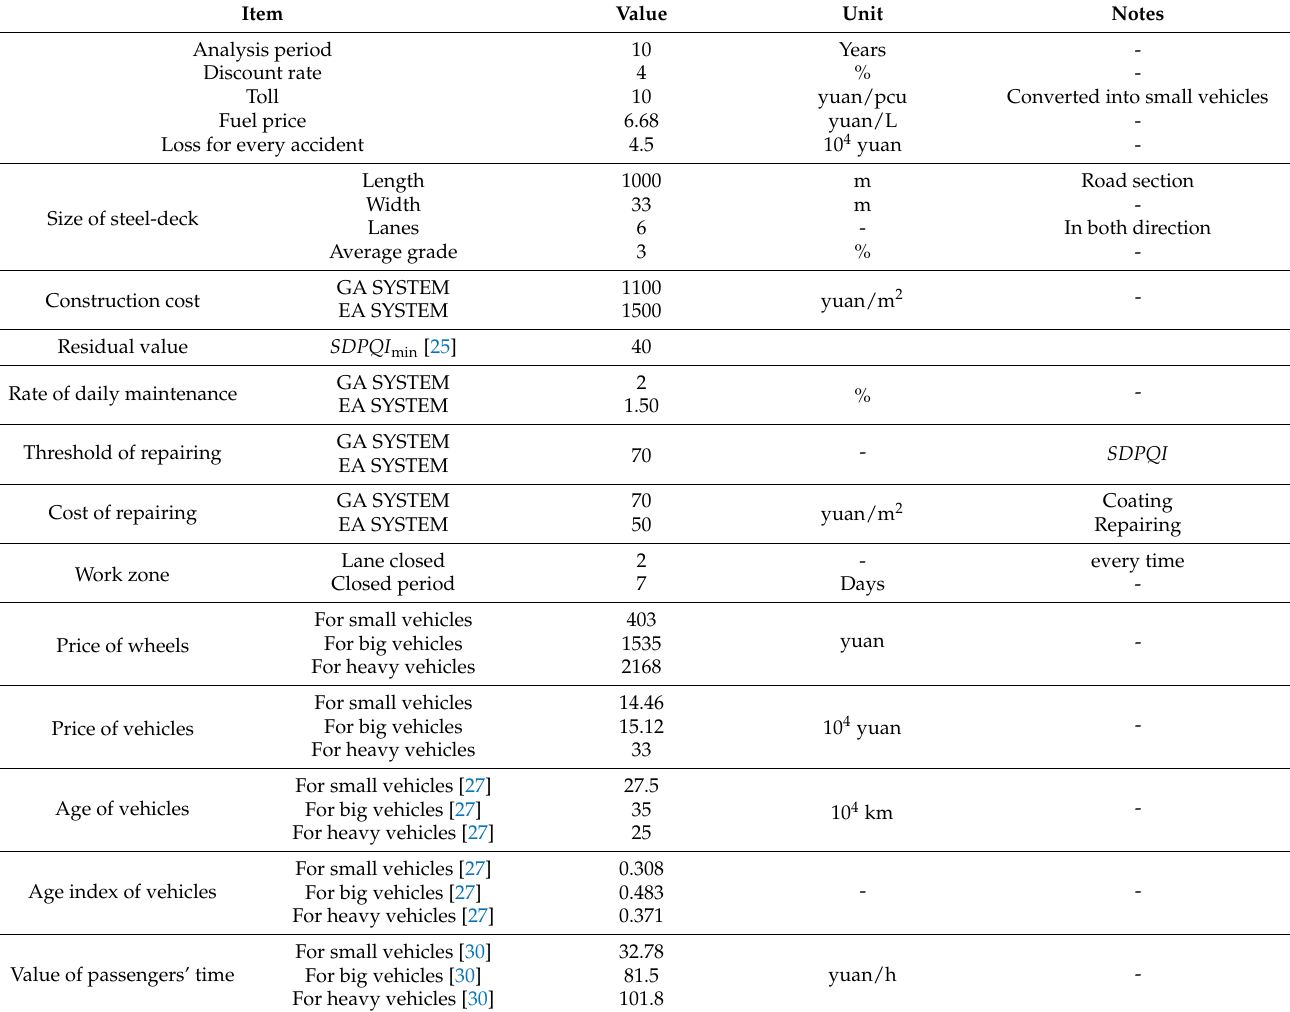
Table 2. Fixed parameters of